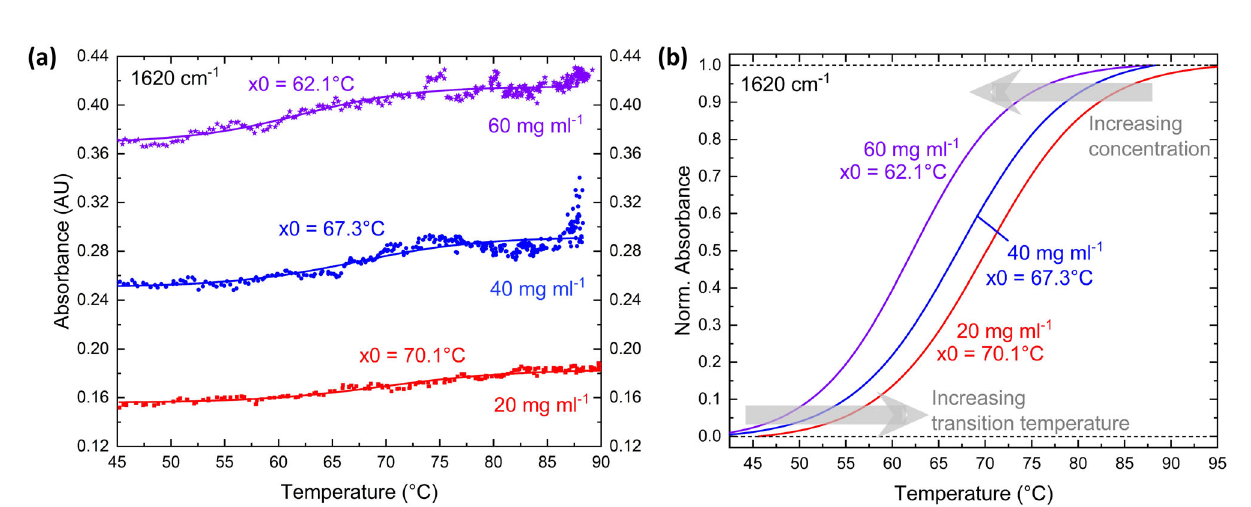
Fig. 6 | Denaturation measurement results at 1620cm − 1 . Investigation of three different concentrations of BSA: 20 (red), 40 (blue), and 60mgml − 1 (violet) and extraction of the transition temperature x 0. a Absolute measurement values (cir- cles) and sigmoidal Boltzmann-Fit curves (solid lines) in absorbance units (AU). the obtained results. The absolute values in absorbance units (AU) in Fig. 6a include crosstalk correction, as already discussed for the con- centration series. To obtain the crosstalk correction value, we use the